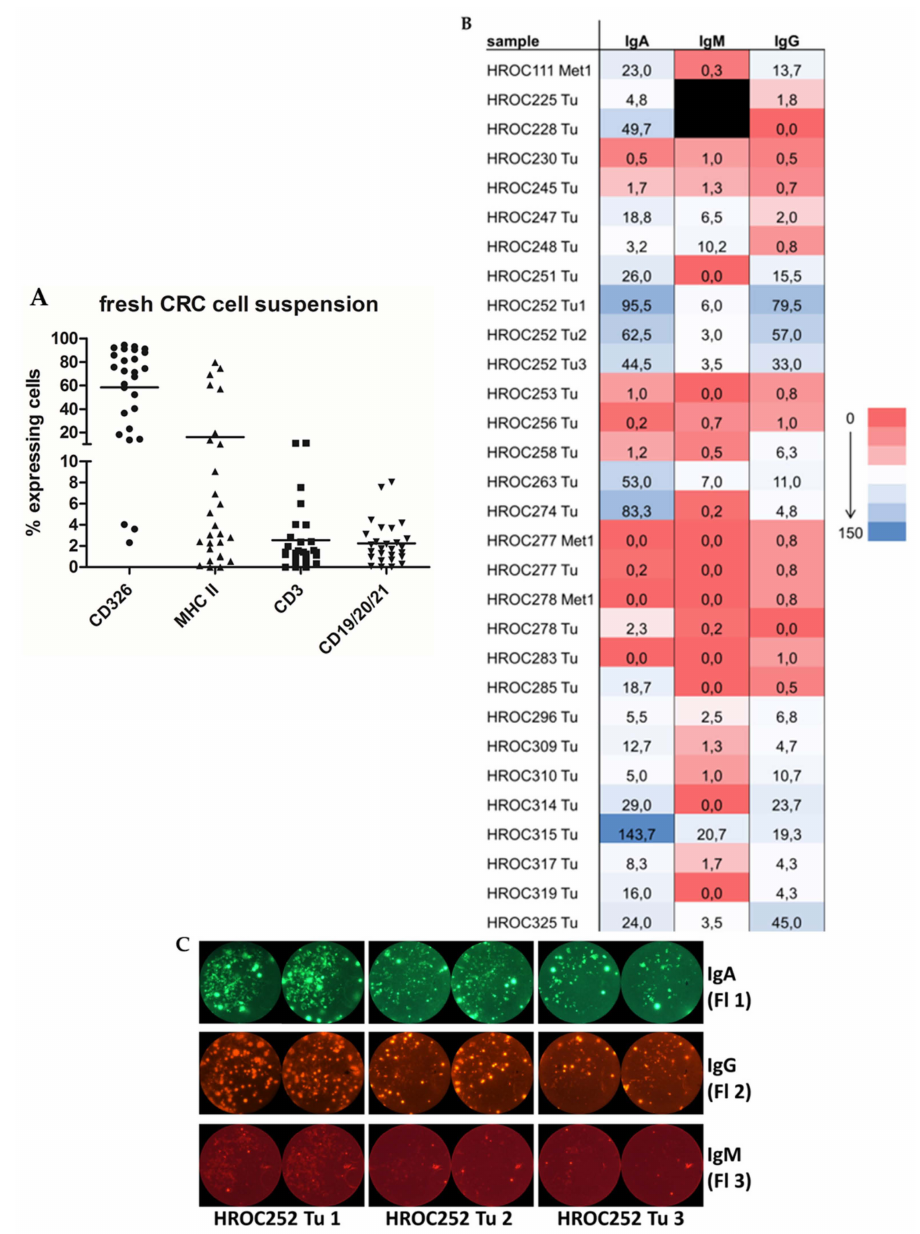
Figure 1. Cellular tumor composition and immunoglobulin secretion. ( A ) Composition of tumor cell suspensions. The cellular composition of the in situ analyzed colorectal carcinoma (CRC) specimen ( n = 27 / 30) was assessed by flow cytometry using the following markers: CD326 (circle, epithelial (tumor) cells), major histocompatibility complex (MHC) class II (upward triangle, antigen-presenting cells), CD3 (square, T cells), and a lineage panel consisting of CD19, CD20, and CD21 (downward triangle, B cells). ( B ) Immunoglobulin (Ig) secretion of tumor cell suspensions. Numbers of IgA, -G, and -M secreting cells for all n = 30 cell suspensions are depicted in the heat map. Mean number of spots per sample and Ig type were plotted in a heat map using the conditional formatting function of Excel. The range goes from no secretors (dark red) to high numbers of secretors (dark blue). Met = metastasis; Tu = tumor; A = adenoma. Samples 225 and 228 could not be analyzed for IgM, thus the respective boxes are marked black. ( C ) Comparison of Ig secretion of three synchronous tumors. FluoroSpots representing IgA (green), -G (orange), and -M (red) secretors for tumors 1, 2, and 3 of patient HROC252 are depicted. The size of the original well of the FluoroSPot plate is 6.2